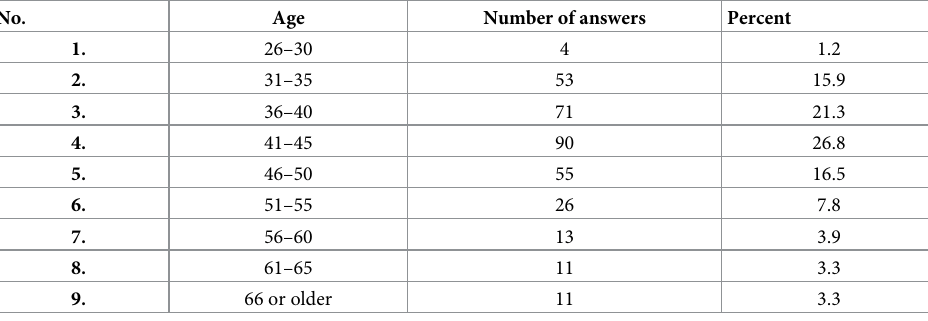
Table 3. Characteristics of the surveyed women by age. N = 334. Source: Study by Ewa Krause. No.